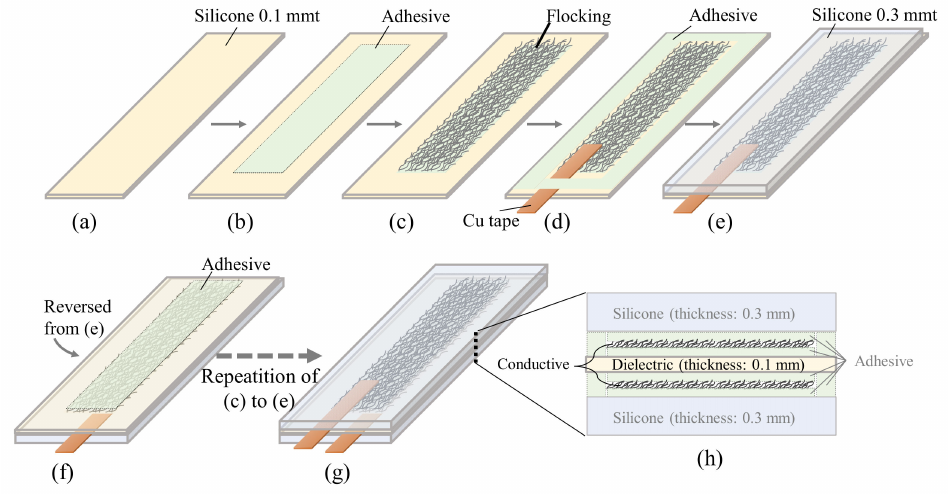
Figure 1. Process flow for fabricating the capacitive-stretch sensor ( a – g ) and its schematic cross section ( h